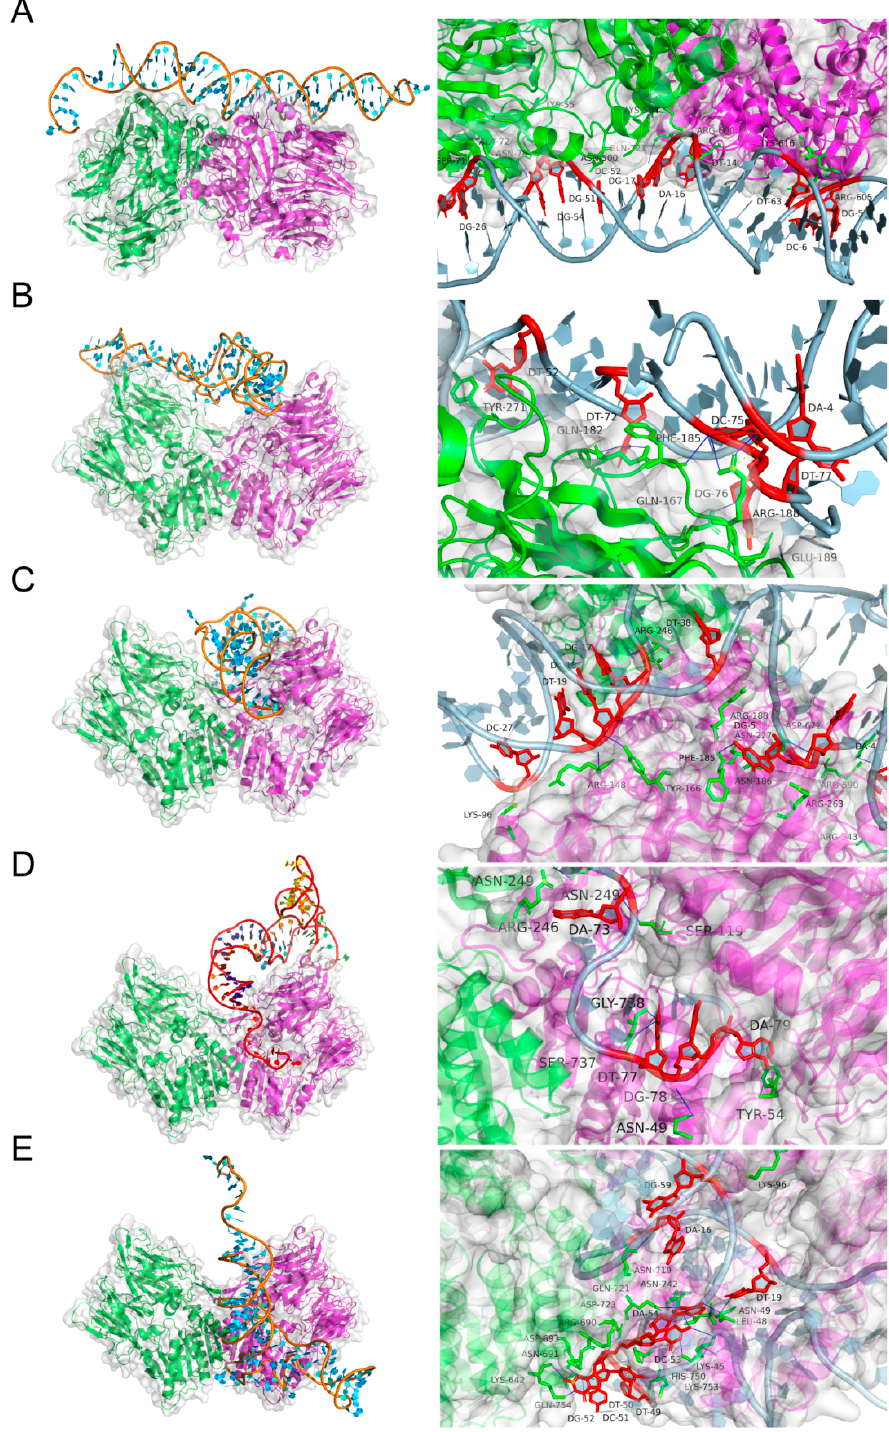
Figure 4. Three-dimensional structure and docking prediction. ( A – E ) Molecular docking models of AptFAP-A1~AptFAP-A5 with FAP proteins and details of the binding sites. The right figure shows the specific binding sites of the candidate aptamer and FAP protein, in which the amino acid residue is shown as stick models in green, the nucleotide residue is shown as stick models in